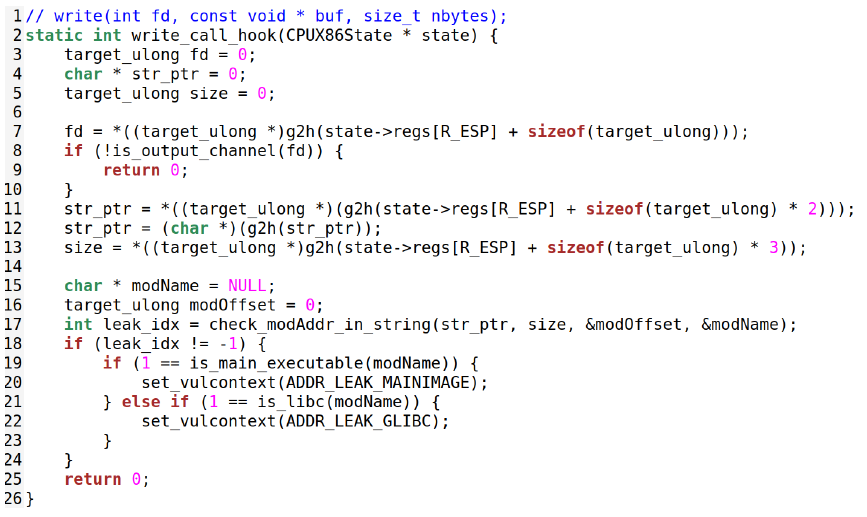
Figure 5. Hook on